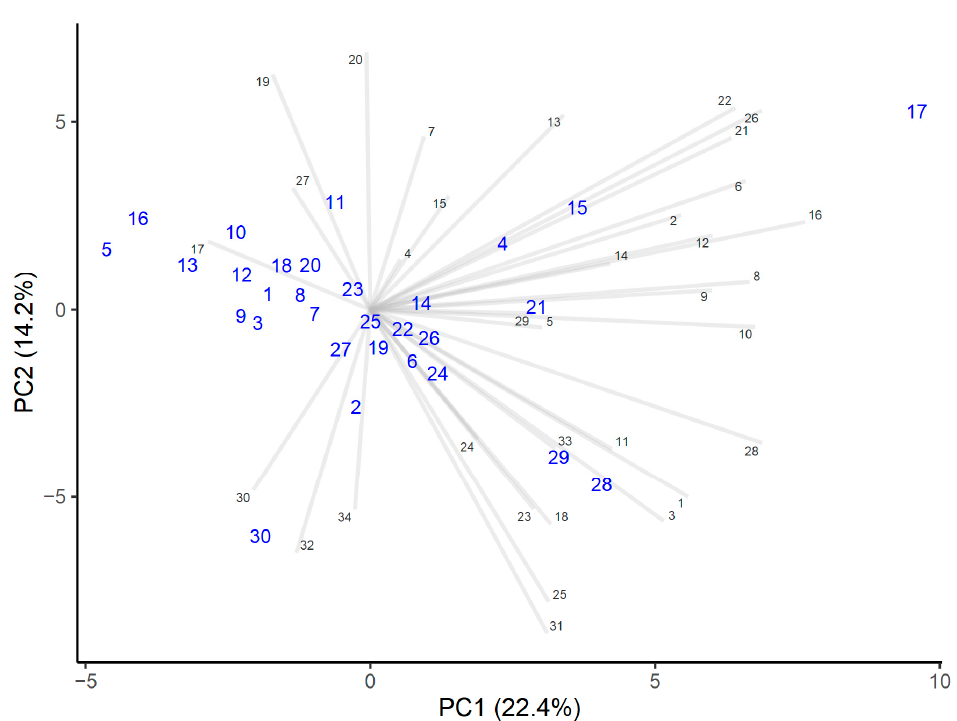
Figure 1. PCA analysis of the intensities of polyphenols. Honey samples are marked by larger blue numbers and polyphenols by smaller numbers marked